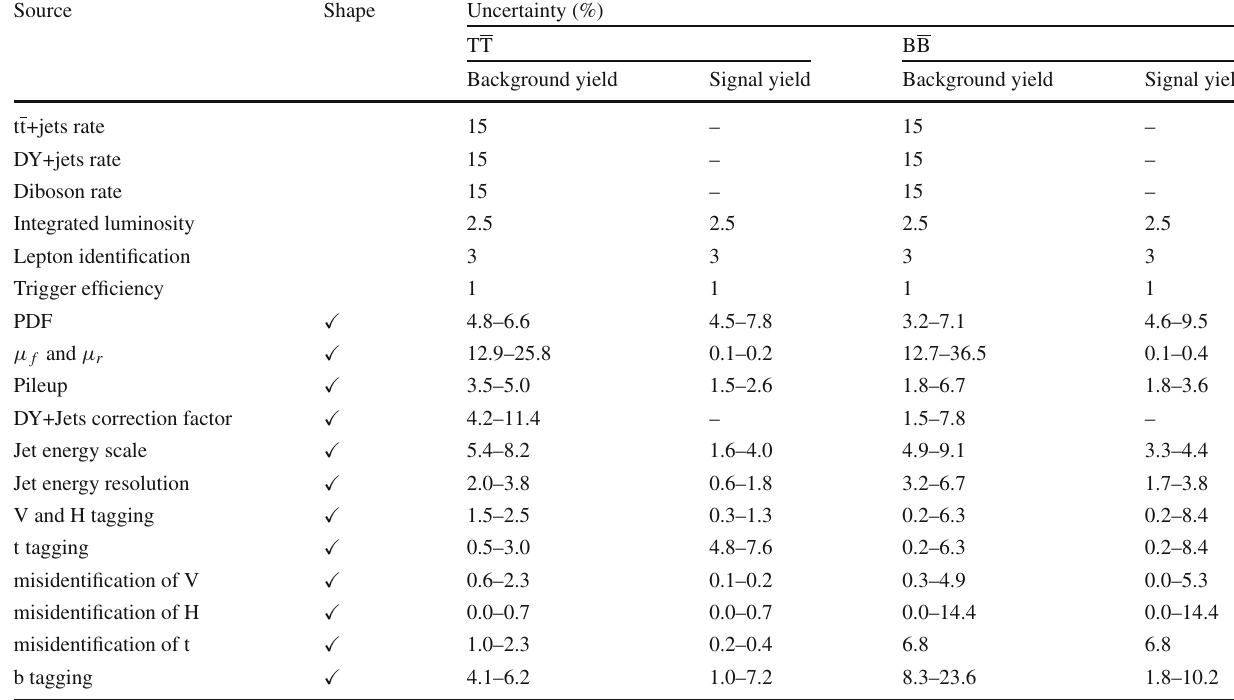
uncertaintyrangeaccountsfortheireffectsontheexpectedyieldsacross all the TT groups or BB categories. The TT and BB signal events cor- respond to the benchmark decay channels tZtZ and bZbZ, respectively, for T and B quark mass m T = m B =